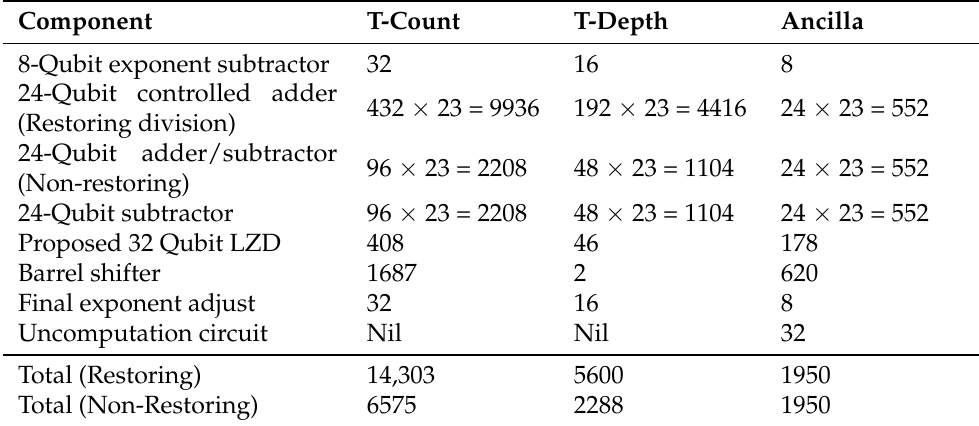
Table 3. Resource utilization of the proposed quantum SPFP division circuit using restoring and Non-restoring division algorithm.